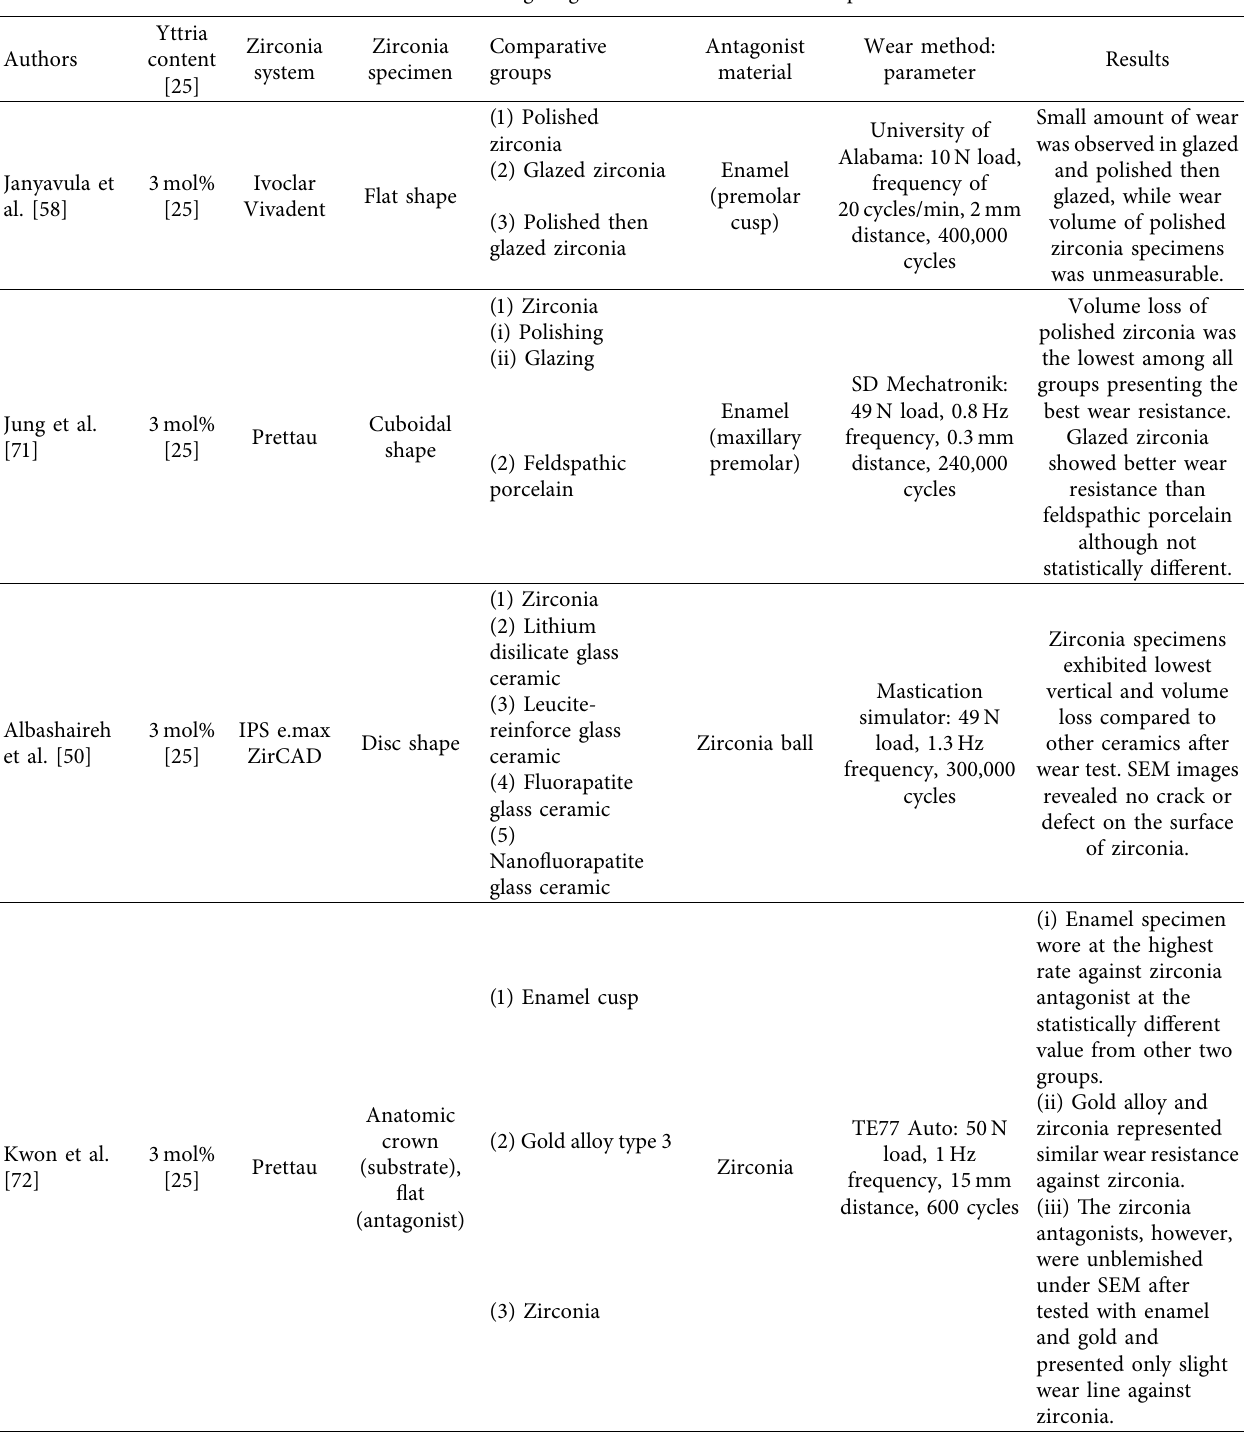
Table 1: Studies investigating wear resistance of zirconia